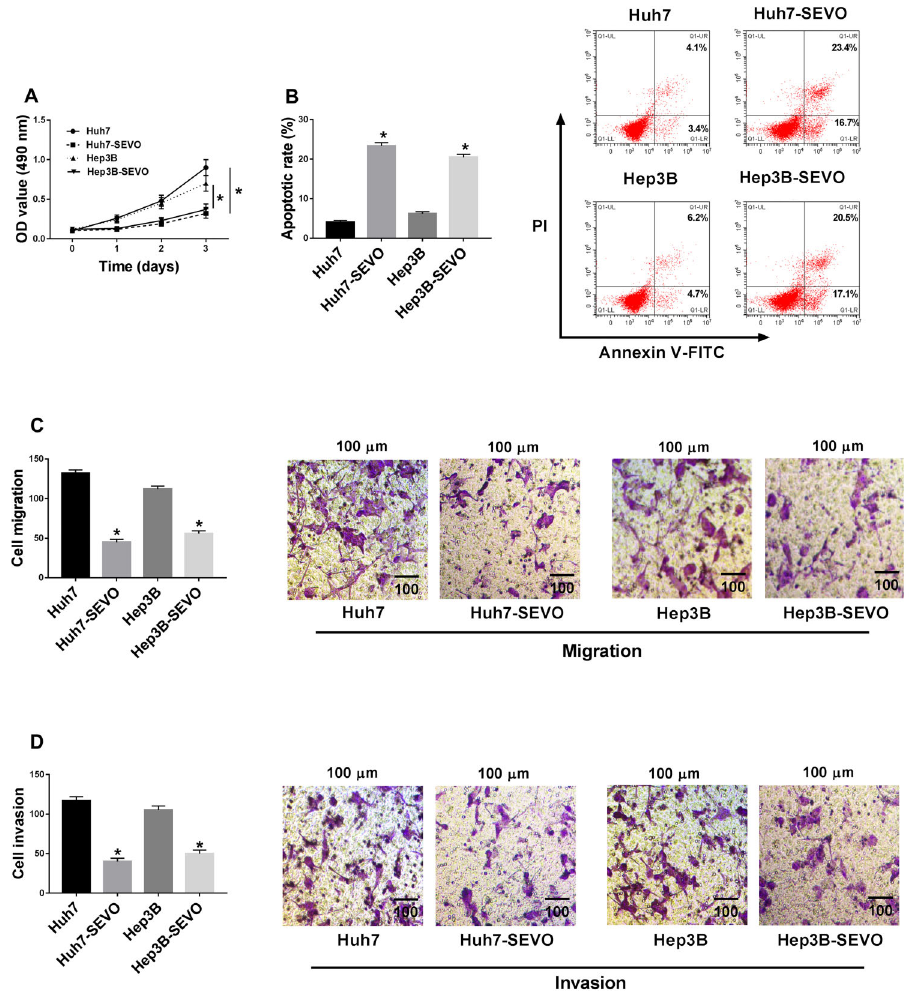
Figure 1. Sevo fl urane (SEVO) suppressed cell proliferation, migration, and invasion and promoted cell apoptosis in hepatocellular carcinoma cells. Huh7 and Hep3B cells were stimulated with 4% SEVO for 48 h. A , MTT assay was performed to determine cell proliferation ability (n=3). B , Flow cytometry was used to analyze cell apoptosis rate (n=3). C and D , Cell migration and invasion were assessed by transwell assays (scale bar: 100 m m) (n=3). Data are reported as means ± SD. *P o 0.05 (Student ’ s t